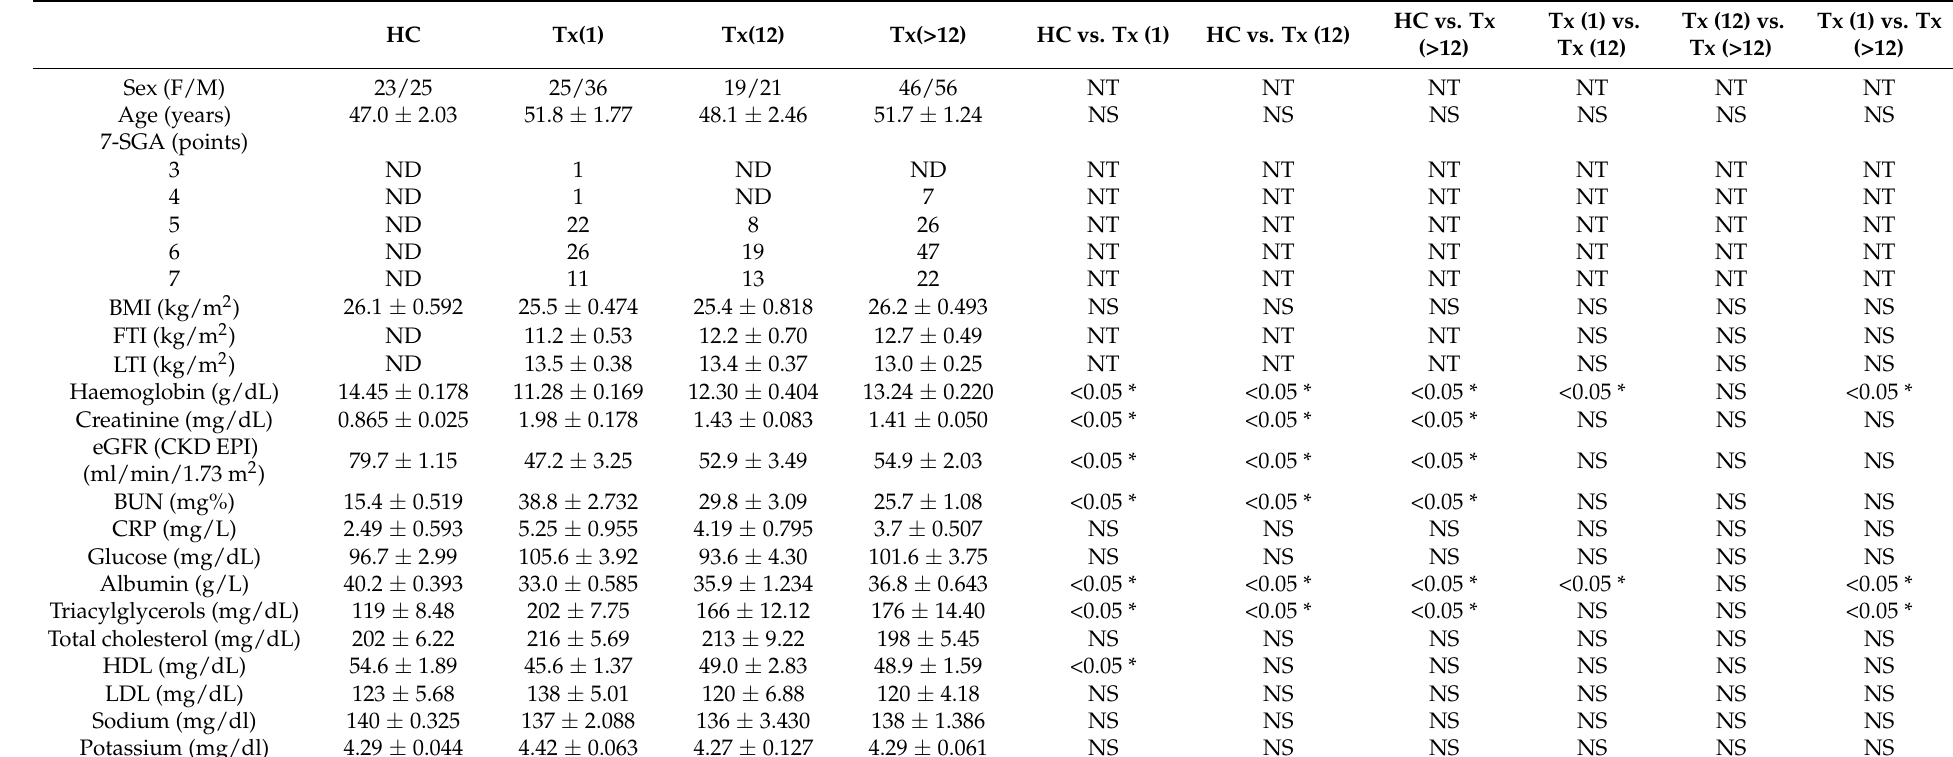
Table 1. Biochemical and anthropometric characteristics of the study